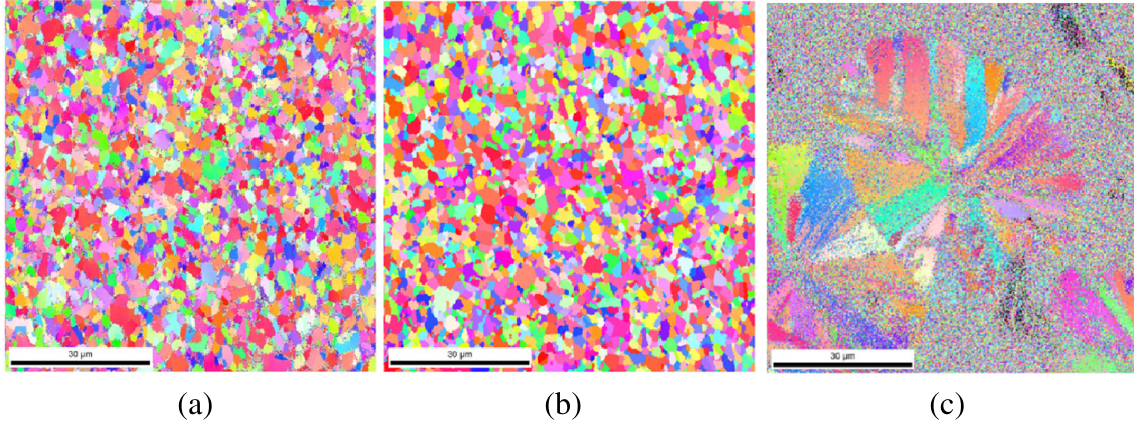
Fig. 6. EBSD images of samples (a) before laser processing, (b) 2.2 kW, 10 cm/s, (c) 2.6 kW, 10 cm/s.